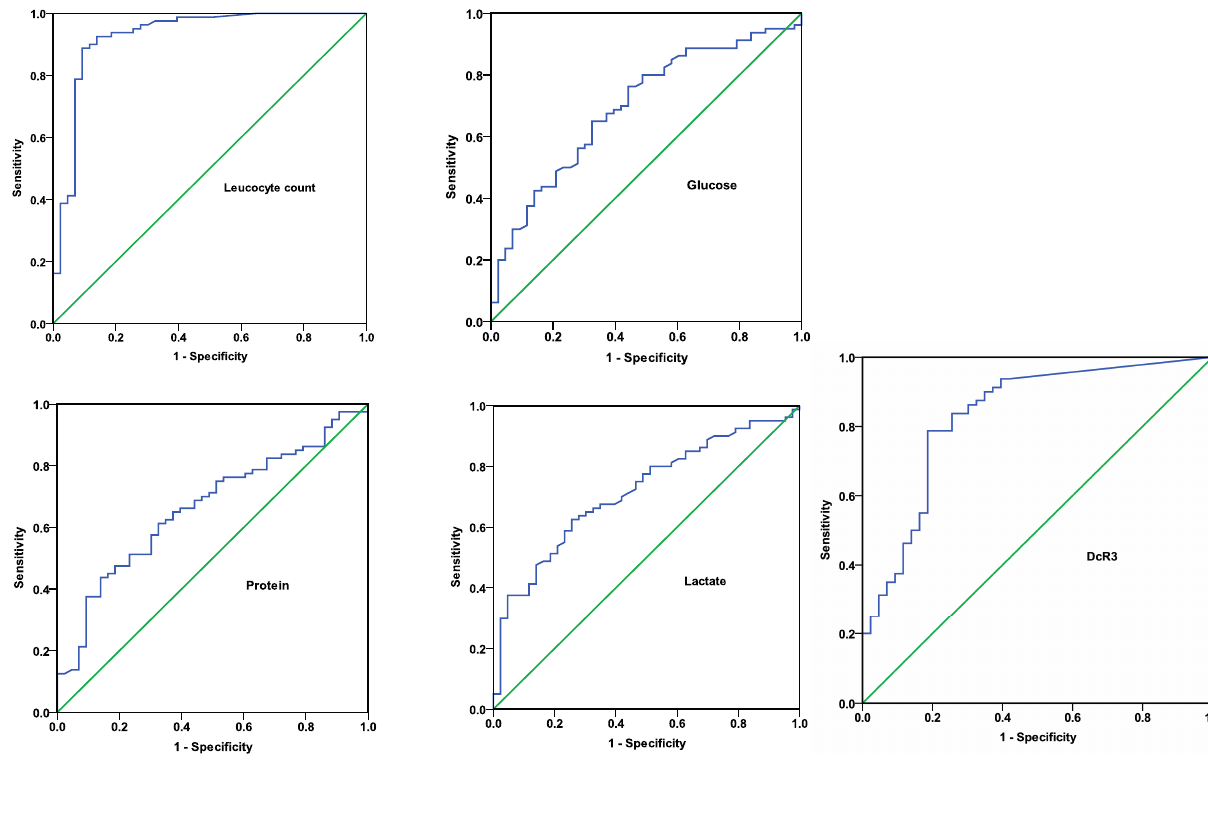
Figure 2. Receiver operating characteristic (ROC) curves of DcR3 and cerebrospinal fluid (CSF) culture markers in predicting bacterial meningitis. All parameters are presented with 95% confidence intervals. Areas under the ROC curve are shown as follows: Leucocyte count: 0.928 (0.872–0.984); Glucose: 0.696 (0.601–0.792); Protein: 0.664 (0.567–0.761); Lactate: 0.717 (0.625–0.808); DcR3: 0.831